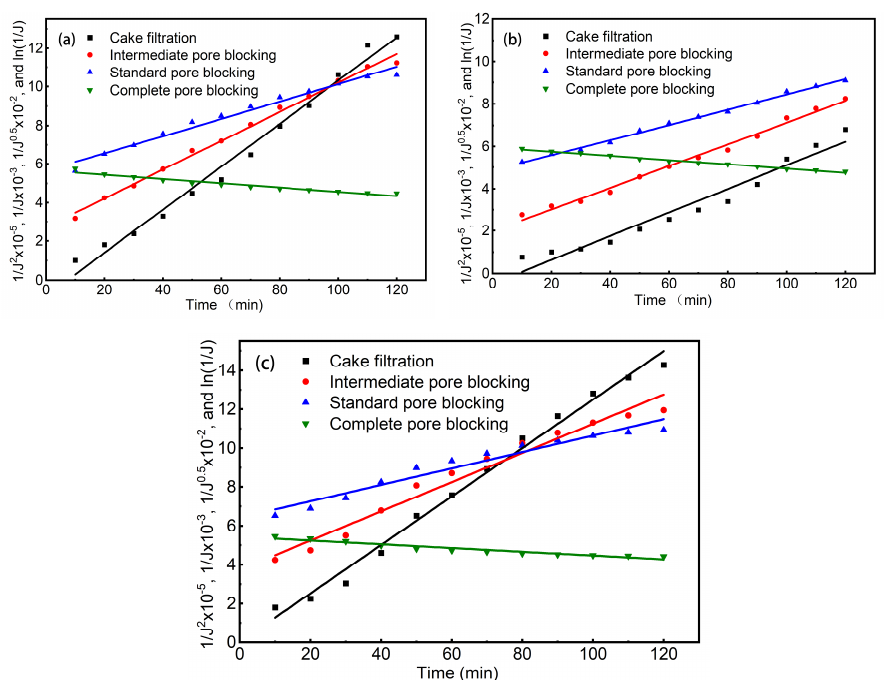
Figure 7. The flux function and time diagrams of four different pore blocking models under different concentrations: ( a ) 30 mg · L − 1 , ( b ) 40 mg · L − 1 and ( c ) 50 mg · L − 1 Table 3. Related parameters of different pore blocking models with different oil concentrations.